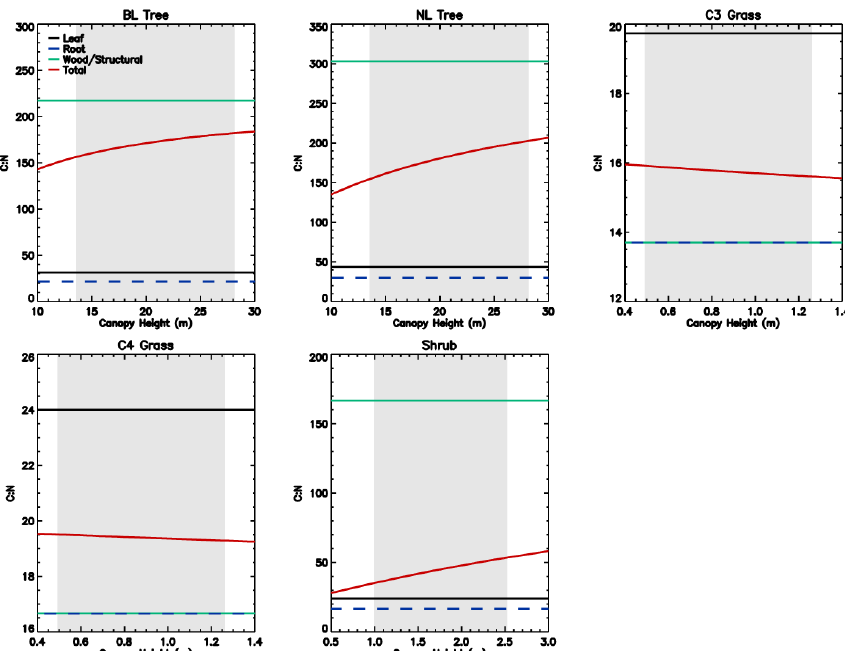
Figure 1. Stoichiometry of the vegetation nitrogen pools as a function of canopy height for individual PFTs at full leaf. Leaf N concentration are defined at the canopy level and are higher than those for the top leaf. The grey region shows the defined range of canopy height within the model. Note that both the x and y scales are very different for each